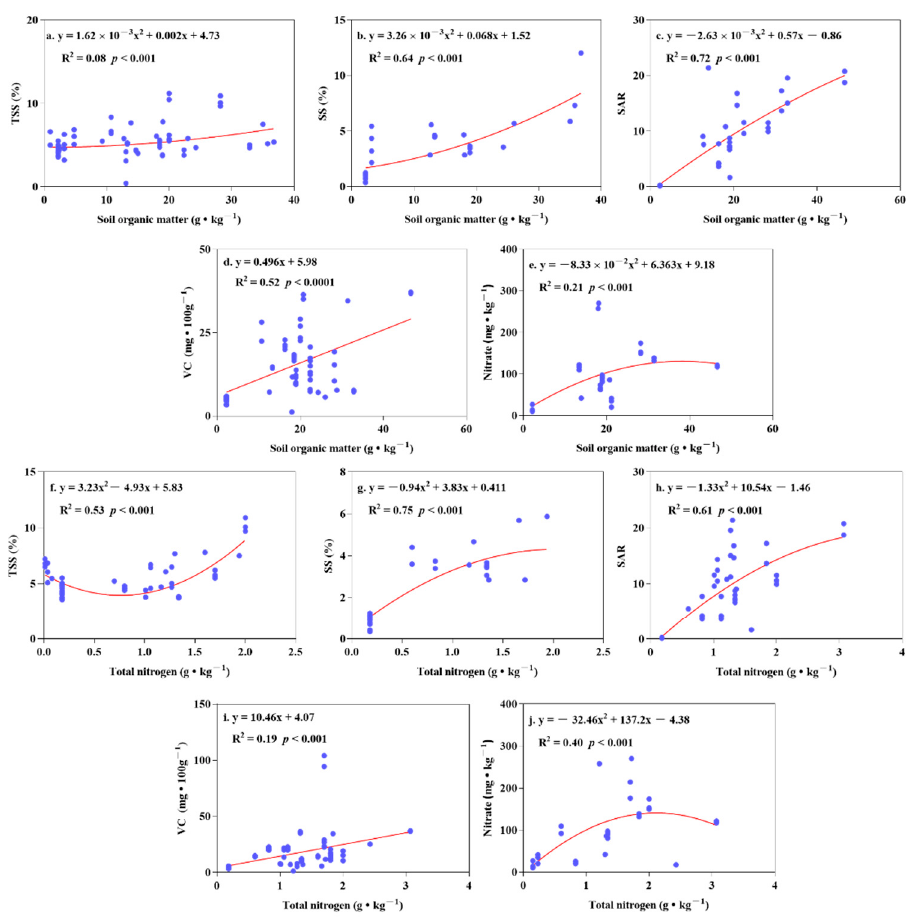
Figure 3. Relationship between soil organic matter, total soil nitrogen, and tomato quality: TSS ( a ), SS ( b ), SAR ( c ), VC ( d ), and nitrate ( e ); TSS ( f ), SS ( g ), SAR ( h ), VC ( i ), and nitrate ( j ).